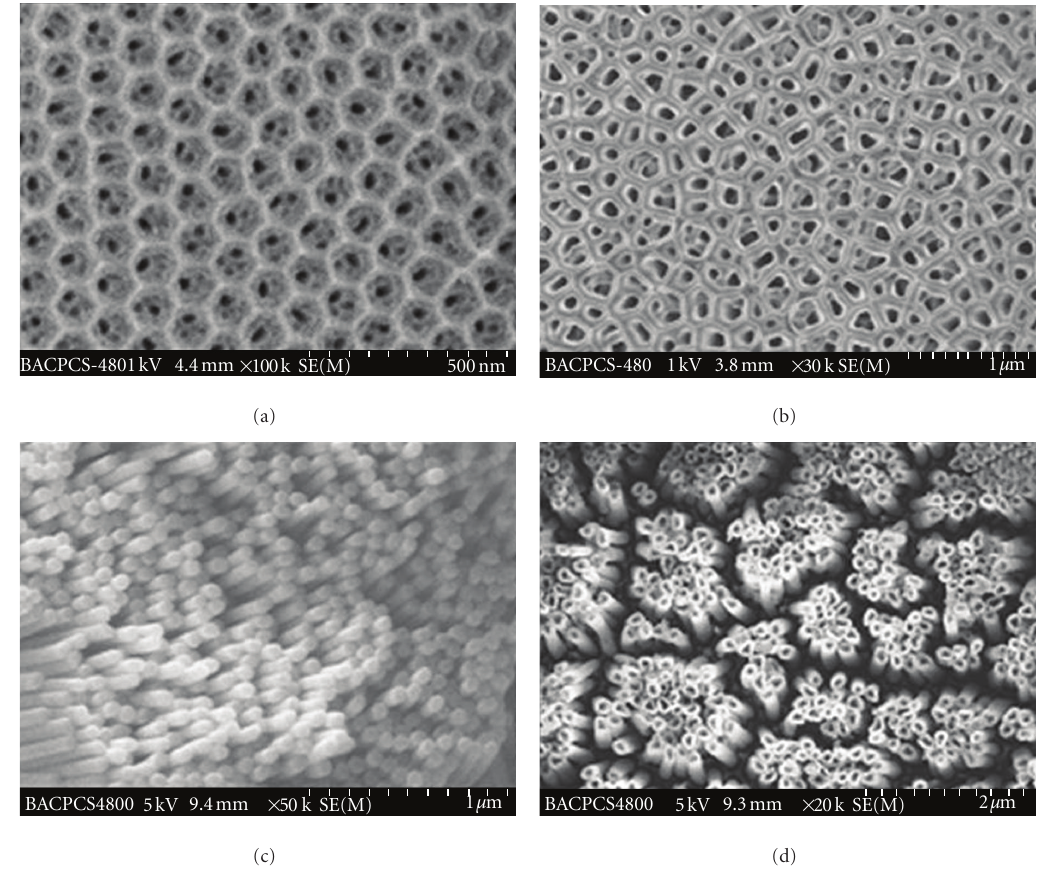
Figure 3: FE-SEM of titanium oxide nanotubes array films: (a) AAO membrane (oxalic acid), (b) AAO membrane (phosphoric acid), (c) surface morphology of titanium oxide nanotubes array films (oxalic acid), and (d) surface morphology of titanium oxide nanotubes array films (phosphoric acid)